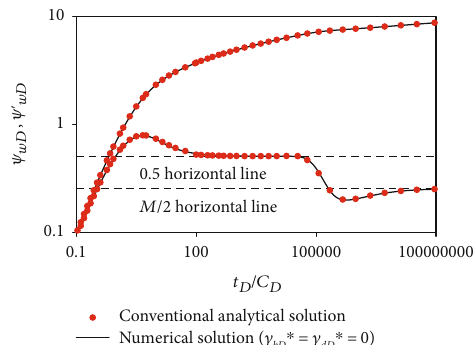
Figure 3: Comparison between the numerical solution and the analytical solution to the pressure drawdown well test model without considering the stress sensitivity e ff ect.